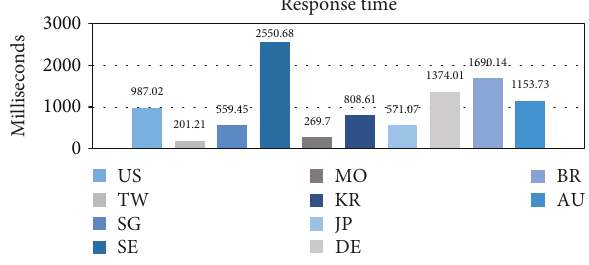
Figure 13: Geographical measurements of the emulation mode with time (response